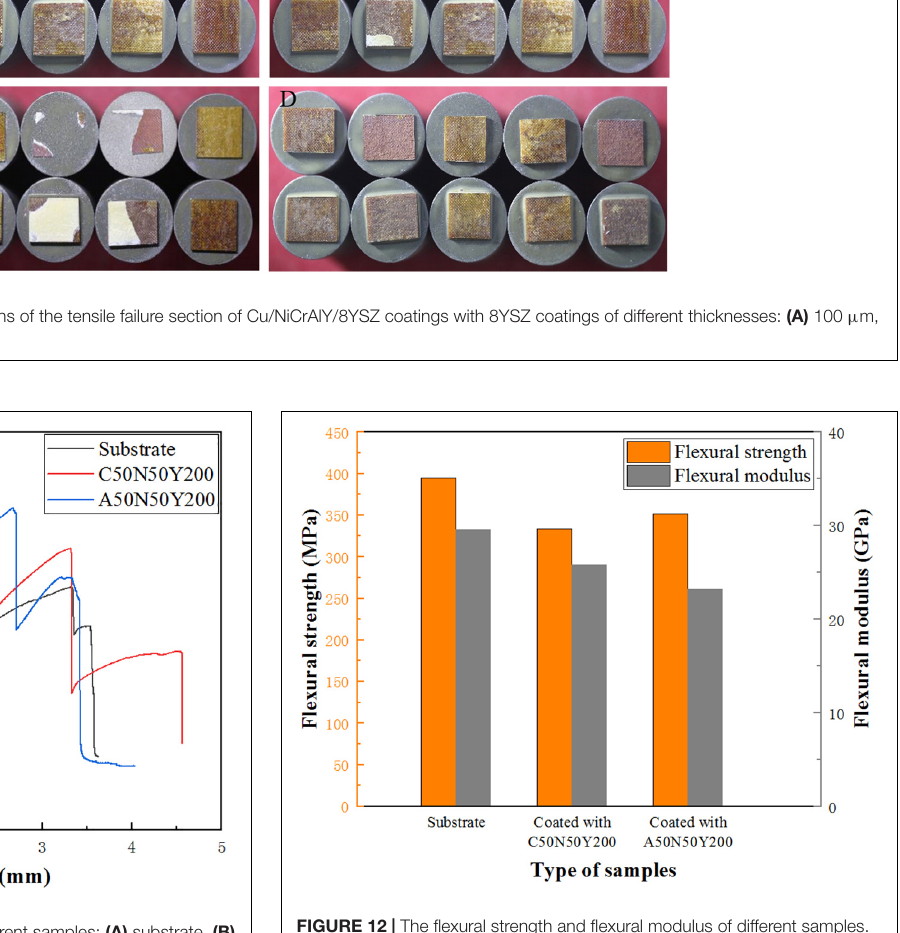
FIGURE 11 | The load-deflection curve of different samples: (A) substrate, (B) substrate coated with A50N50Y200, (C) substrate coated with C50N50Y200.